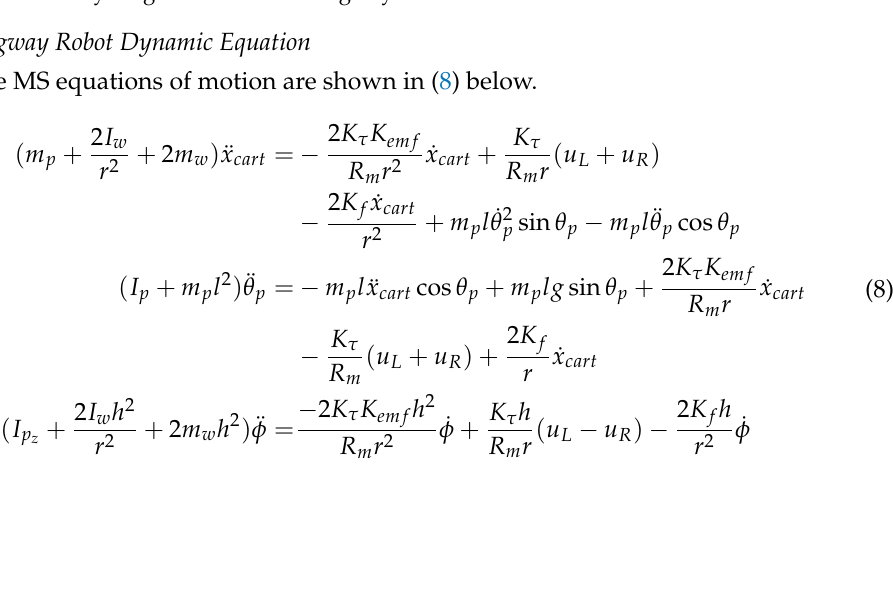
Figure 2. Free body diagram of the mini-Segway